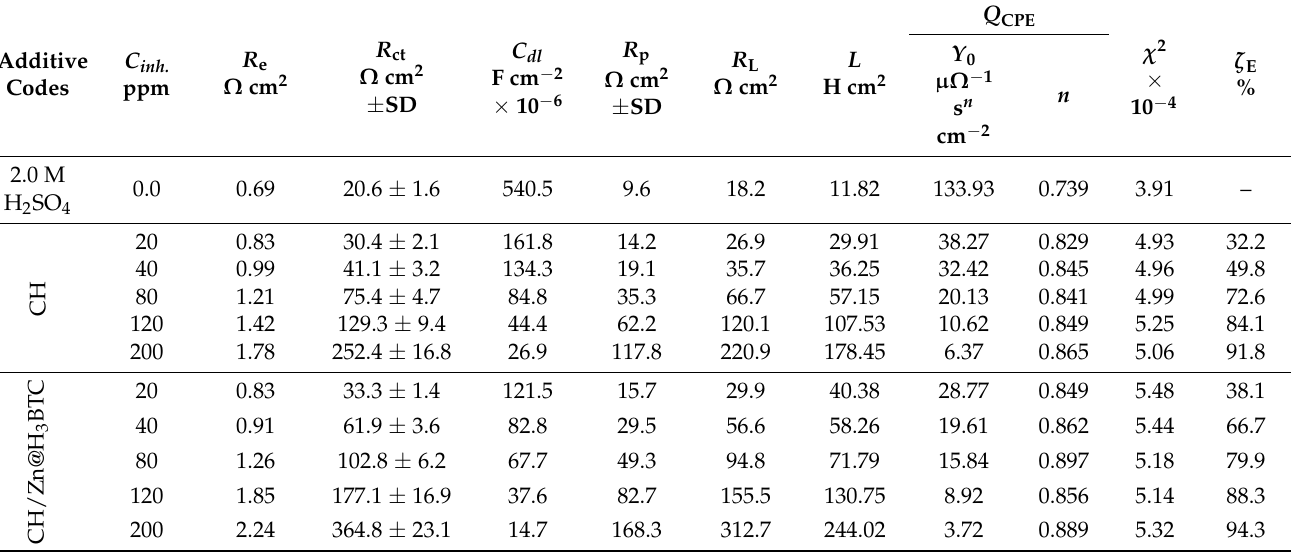
Table 2. EIS parameters achieved for duplex steel in in 2.0 M H 2 SO 4 solution in the absence and presence of various concentrations of CH and CH/Zn@H 3 BTC at 50 ◦